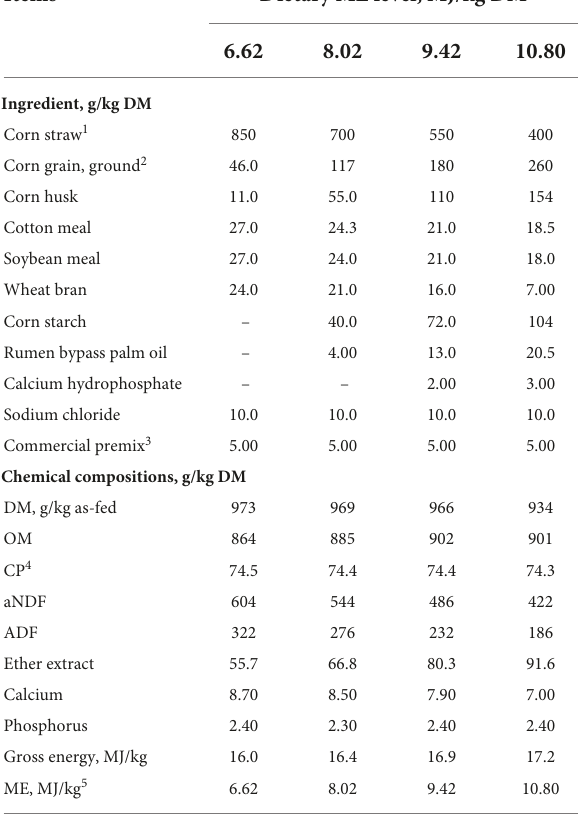
TABLE 1 Ingredients and chemical composition of experimental